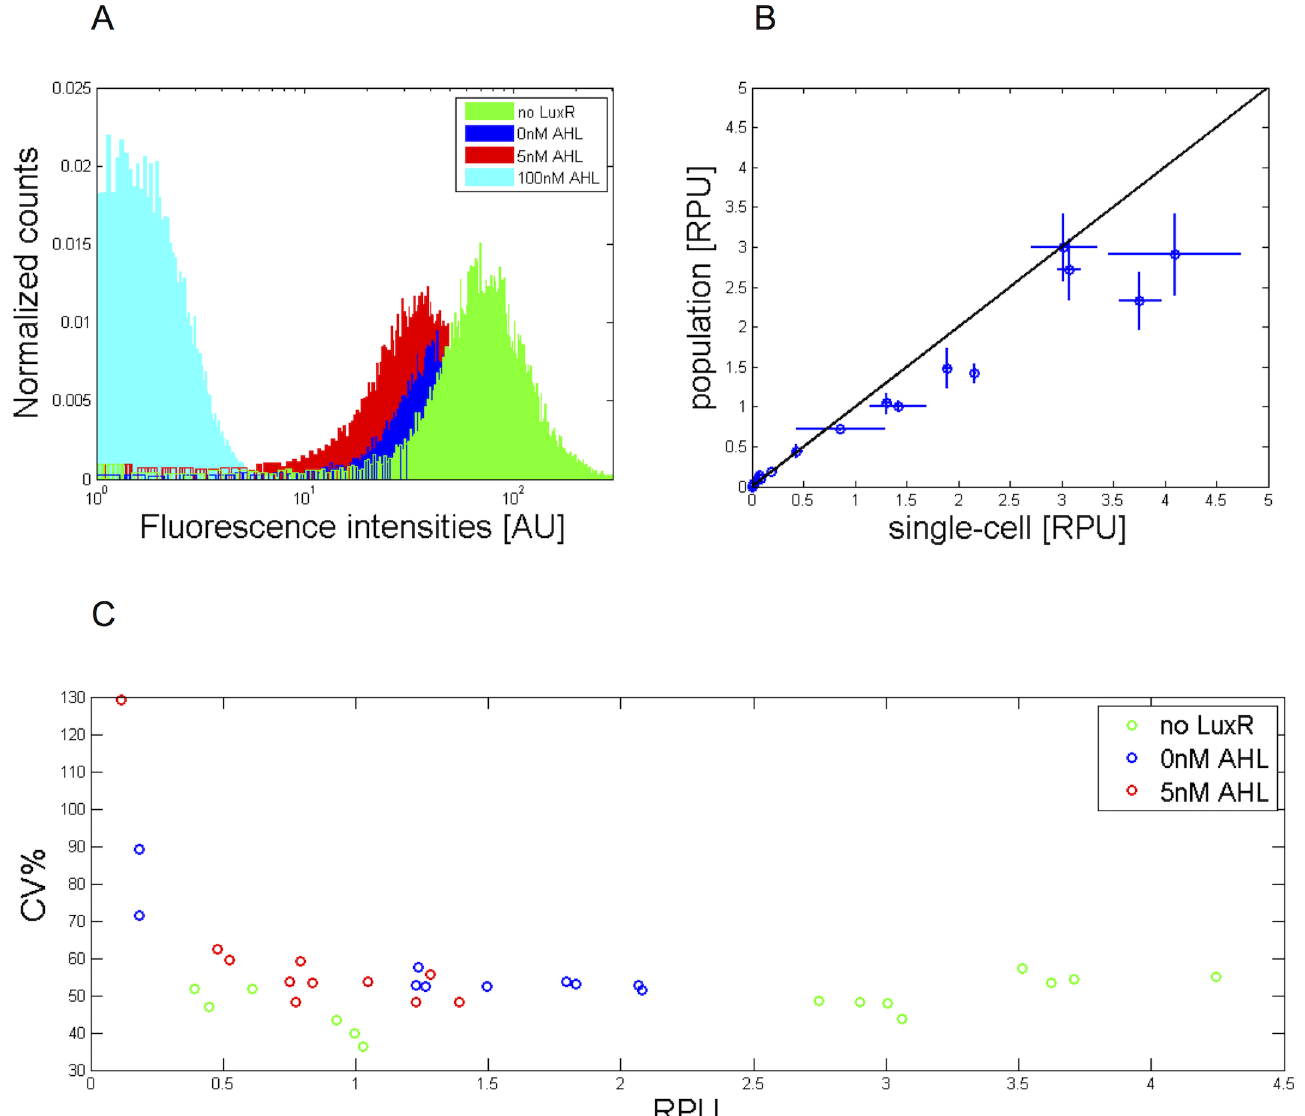
Fig 6. Single-cell measurements of the activity of the LuxR-repressible promoters. A) Representative fluorescence distributions for BBa_J107100 promoter assayed in constitutive mode (green) and regulated mode with no (blue), intermediate (red) and full (cyan) induction. B) Promoter activity obtained via population-based measurements versus single-cell measurements. Blue circles represent average RPU values, horizontal and vertical error bars represent the 95% confidence intervals. The solid black line is the y = x line. C) Cell-to-cell variability, in terms of CV, is reported as a function of